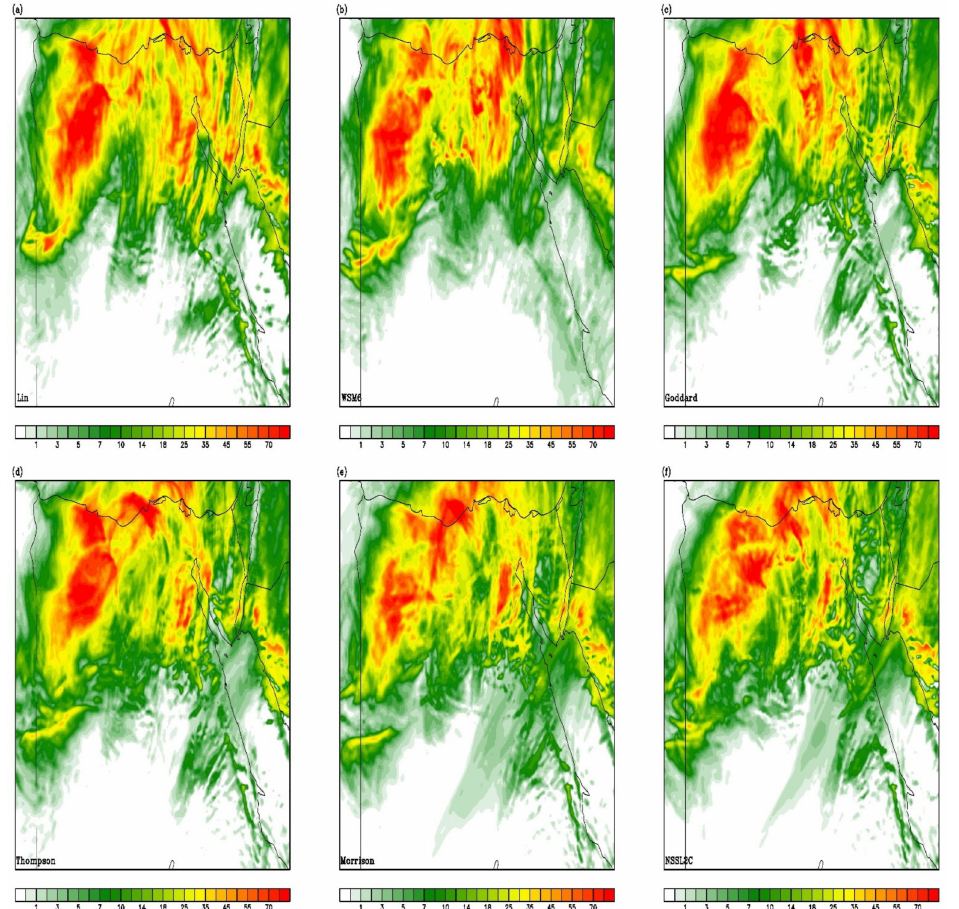
Figure 4. 24 h accumulated rainfall on 12 March 2020 simulated from WRF with microphysics schemes ( a ) Lin, ( b ) WSM6, ( c ) Goddard, ( d ) Thompson, ( e )Morrison, ( f ) NSSL2C.